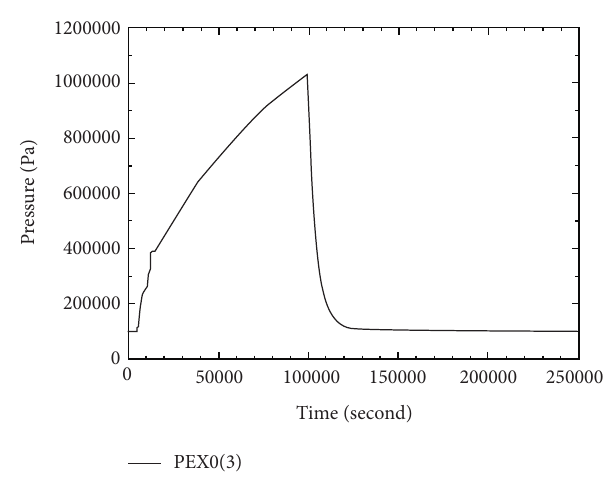
Figure 16: Pressure in